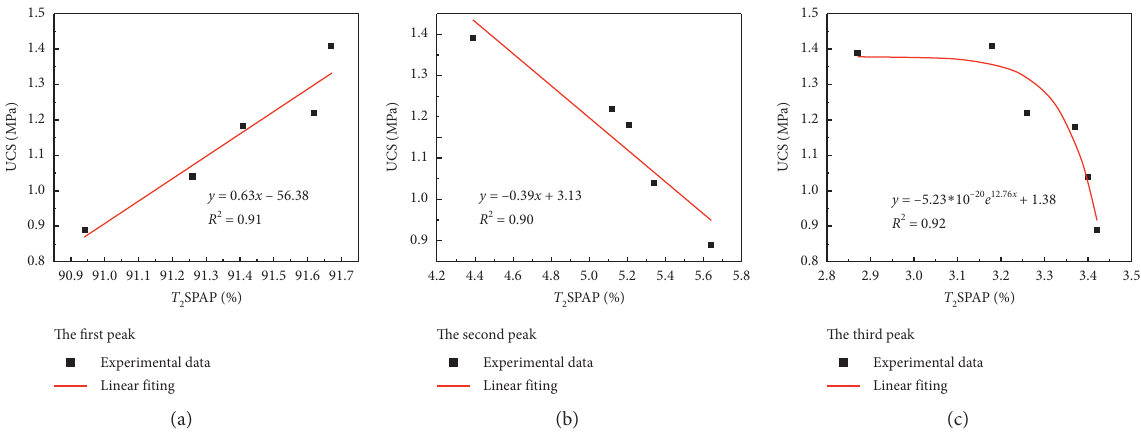
Figure 9: Relationship between strength and T 2 SPAP. (a) First peak; (b) second peak; and (c) third